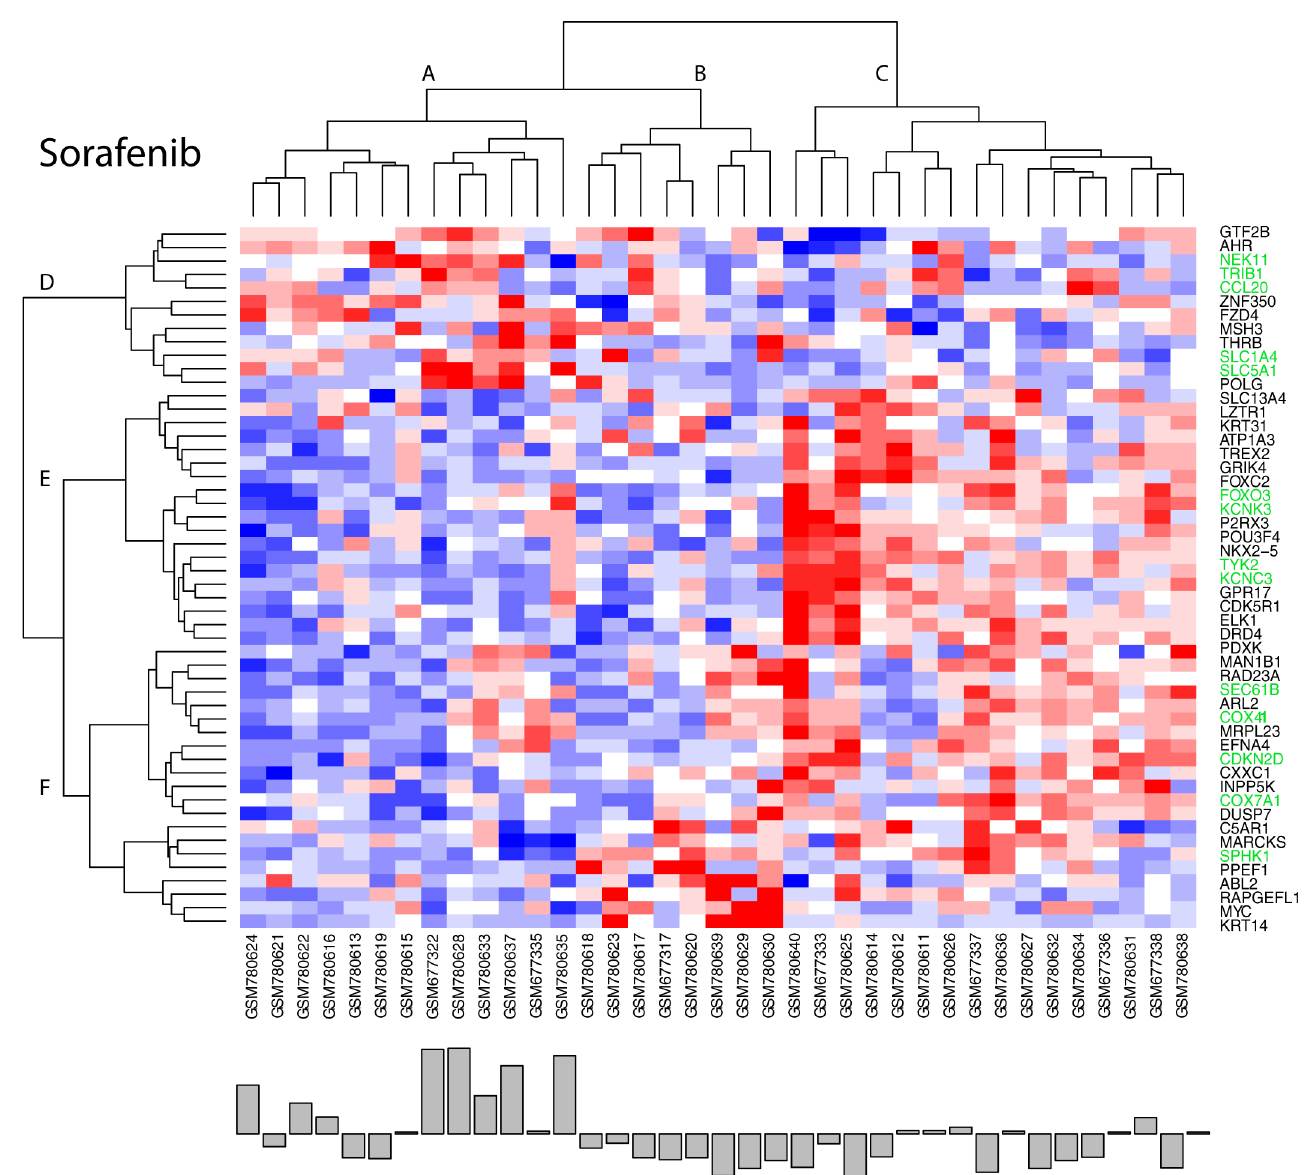
Fig 9. Clustered (Euclidean distance metric, Wards linkage) plot of 51 gene expressions (top panel) selectedfrom genes in the GSEA pathways that have a significant (p < 0.2) correlation with the response data. Expressions are colored spectrallyfrom blue (under) to red (over). Bottom panel representspatient responses, orderedaccordingto the clusteredgenes. A Student’s t-test comparisonof the patient responsesin clade A comparedto clades B and C has a significanceof p = 6.70e-5. Green labels at the right edge identify genes contributing the most to pathway fitness scores (cf. Table 2